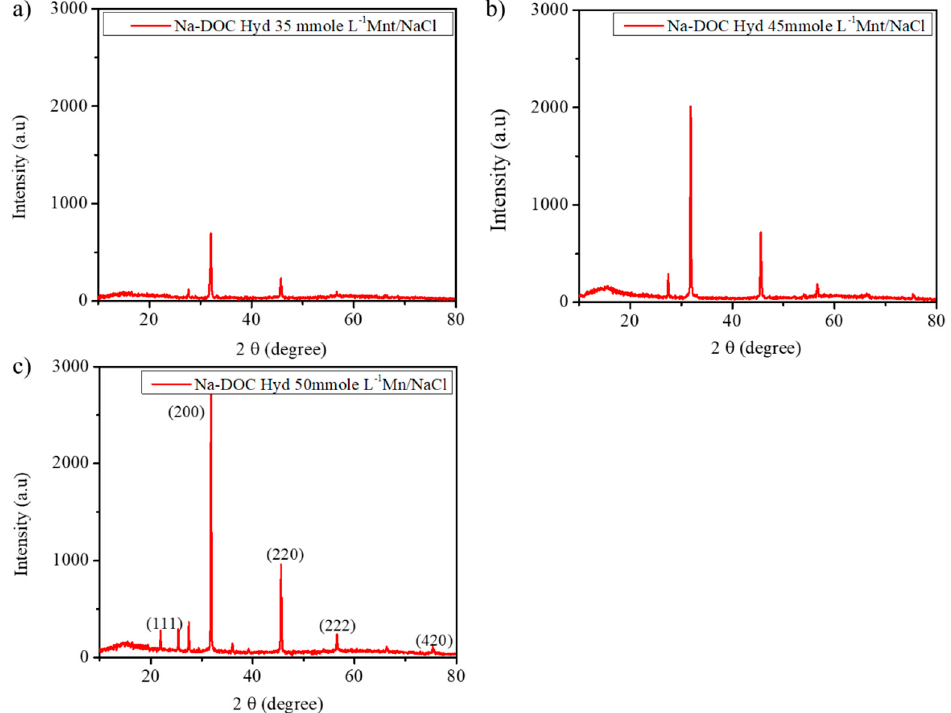
Figure 4. XRD patterns of the gels with 60 mmole L − 1 sodium deoxycholate (Na-DOC) and 35, 45 and 50 mmole L − 1 Mnt/NaCl (1:1 mmole L − 1 concentration ratio of Mnt/NaCl used).